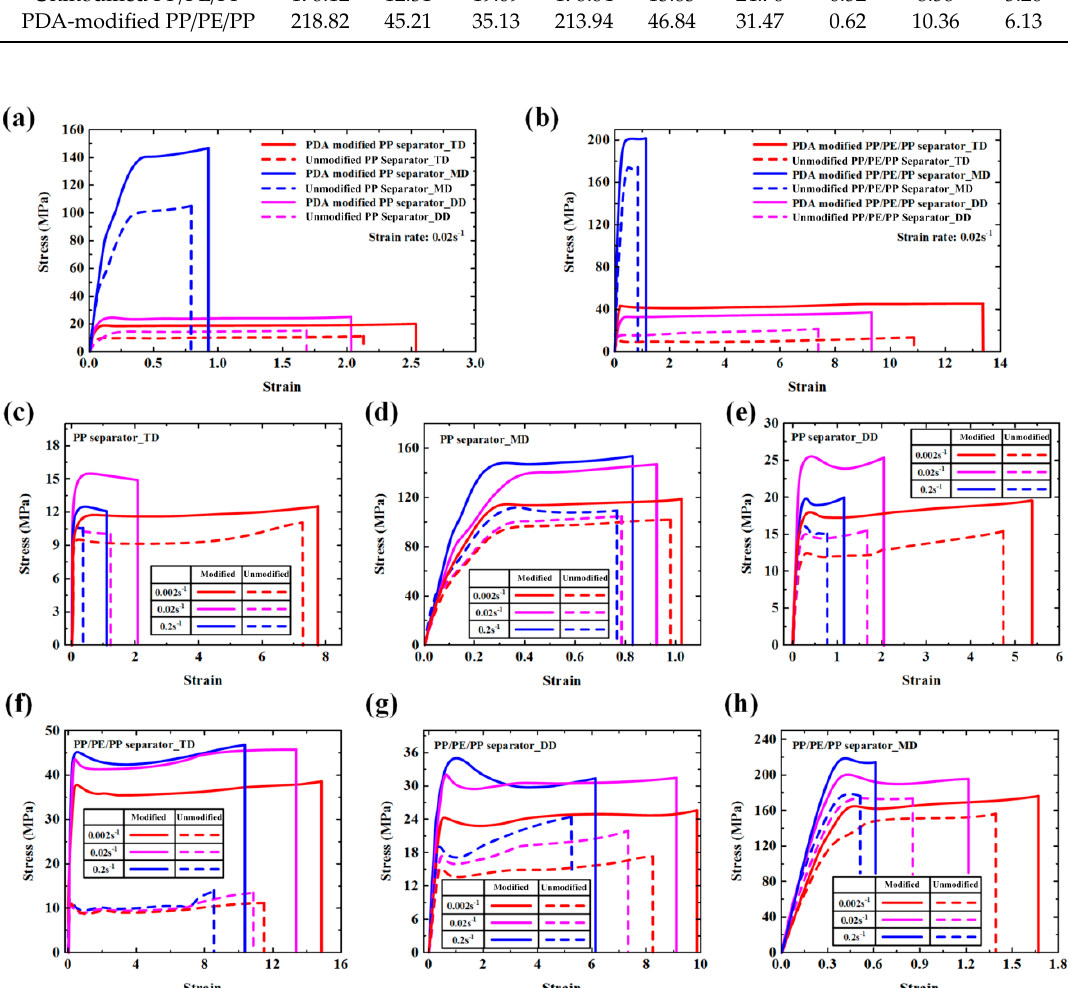
Figure 9. Mechanical properties of unmodified and PDA-modified separators: (a,b) stress-strain curves along transverse direction (TD), machine direction (MD), and diagonal direction (DD); (c–h) stress-strain curves under three strain rates (0.002 s − 1 , 0.02 s − 1 and 0.2 s − 1 ). Table 2. Material parameters of unmodified and PDA-modified separators along transverse direction (TD), machine direction (MD), and diagonal direction (DD) under strain rates 0.002 s – 1 .